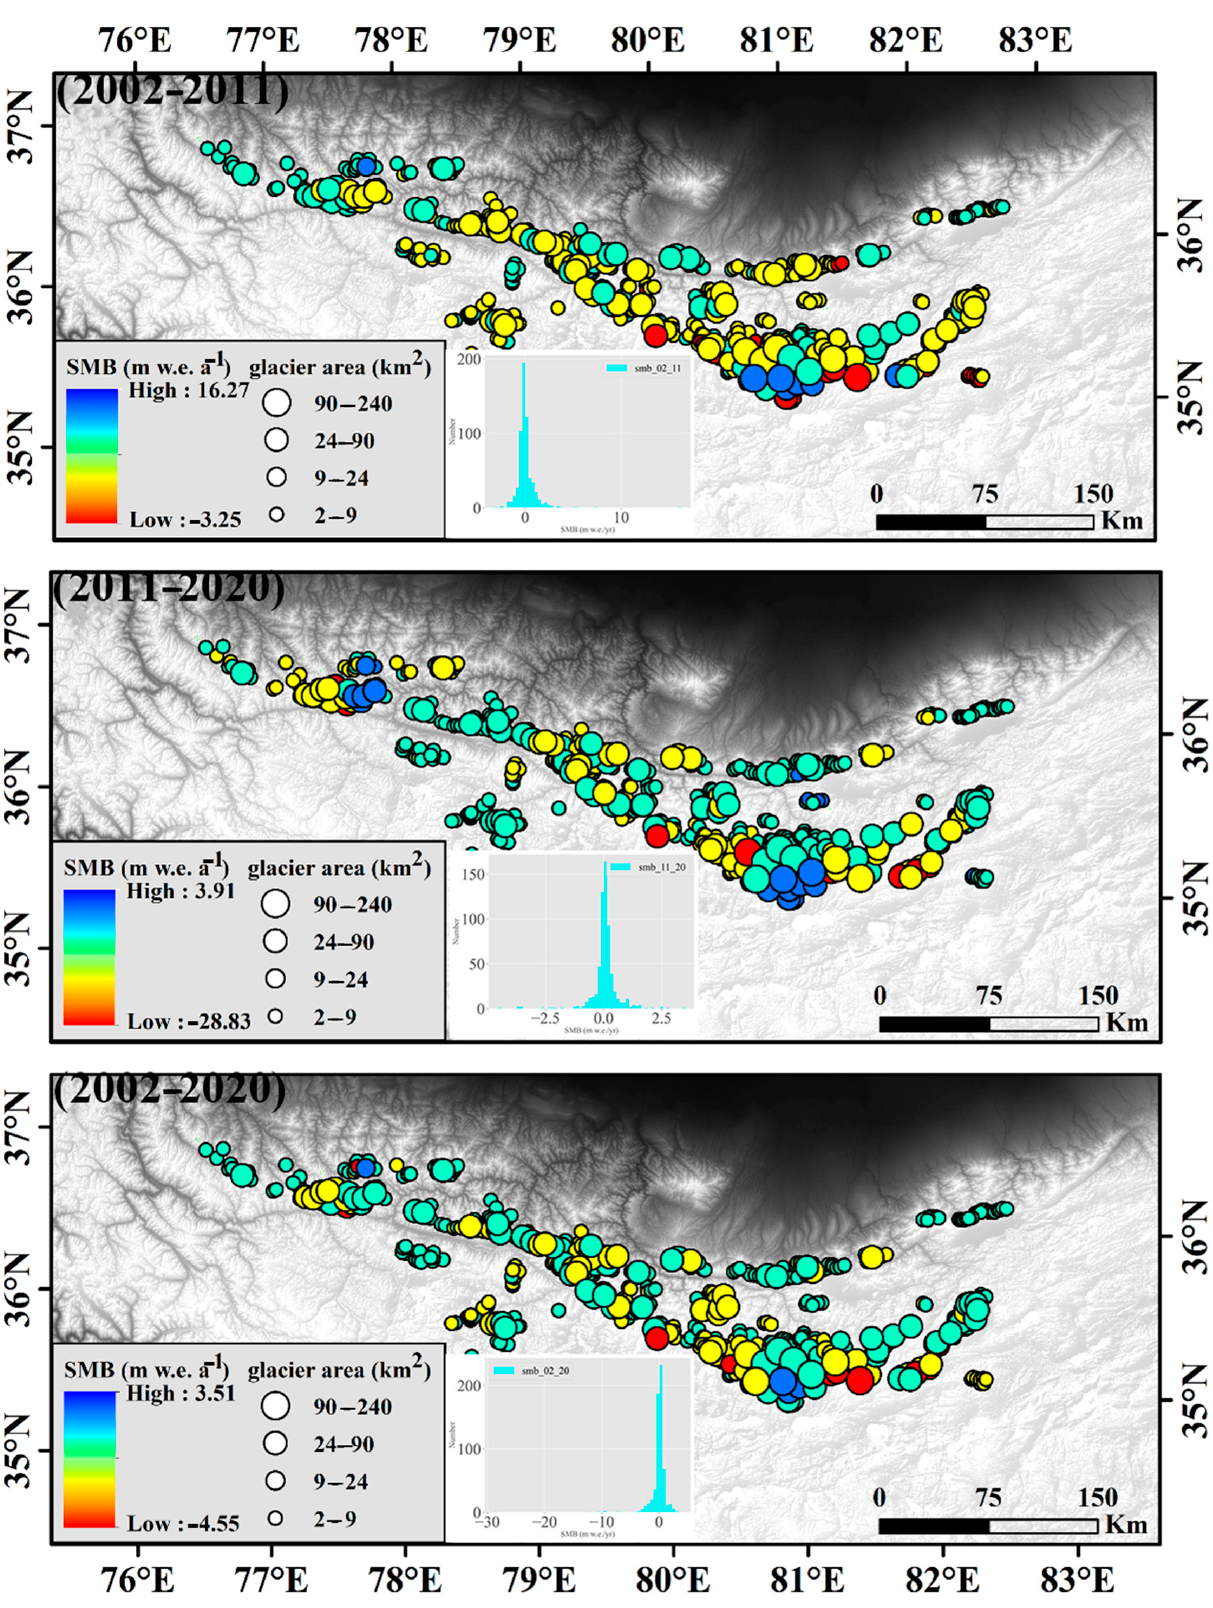
Figure 4. Glacier SMB temporal alterations in WK during 2002–2011, 2011–2020, and Table 4. Averaged glacier elevation change (GEC), in a unit of m a (cid:2879)(cid:2869) , comparing our results and others.